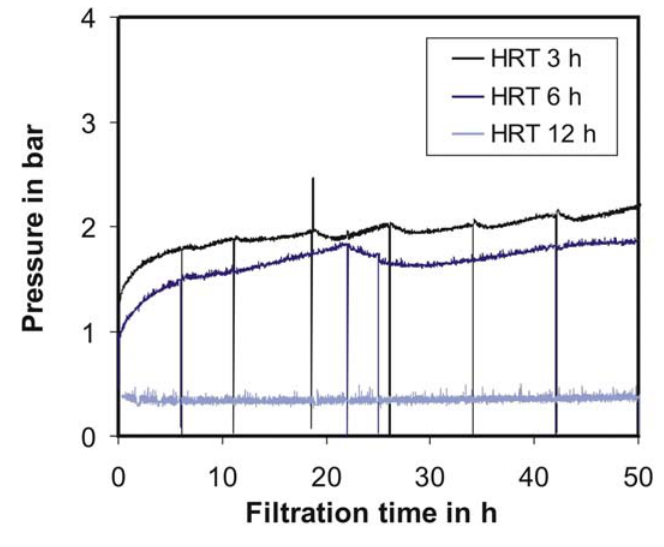
Figure 4. Fouling suppression during continuous cellulose conversion with different hydraulic residence times (HRT) from 3 to 12 h; c pH = 4.66, n = 100 min − 1